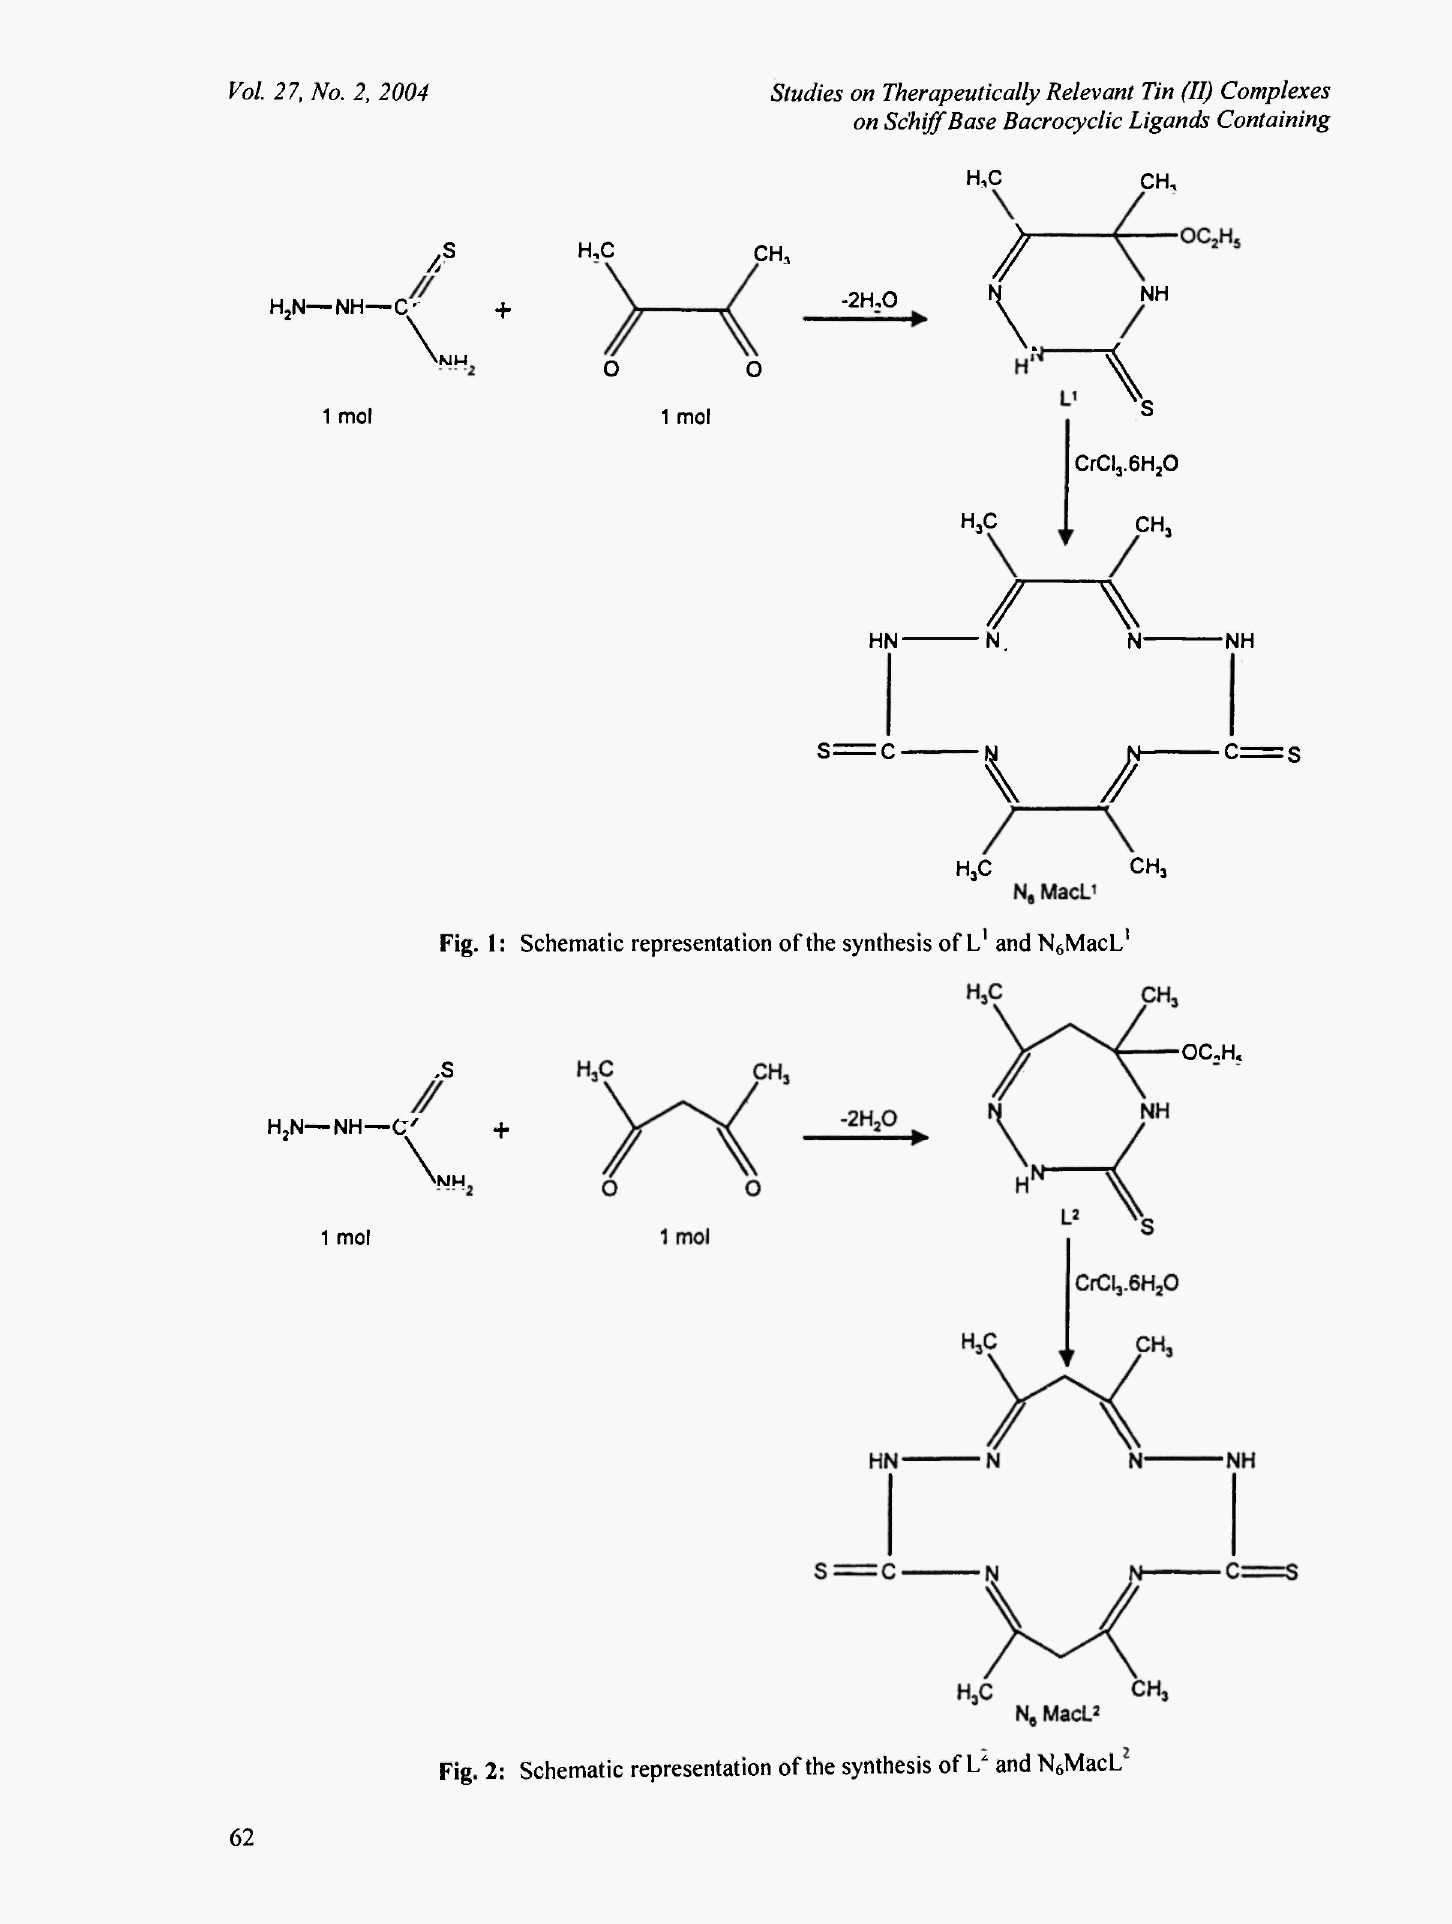
Fig. 2: Schematic representation of the synthesis of L andN 6